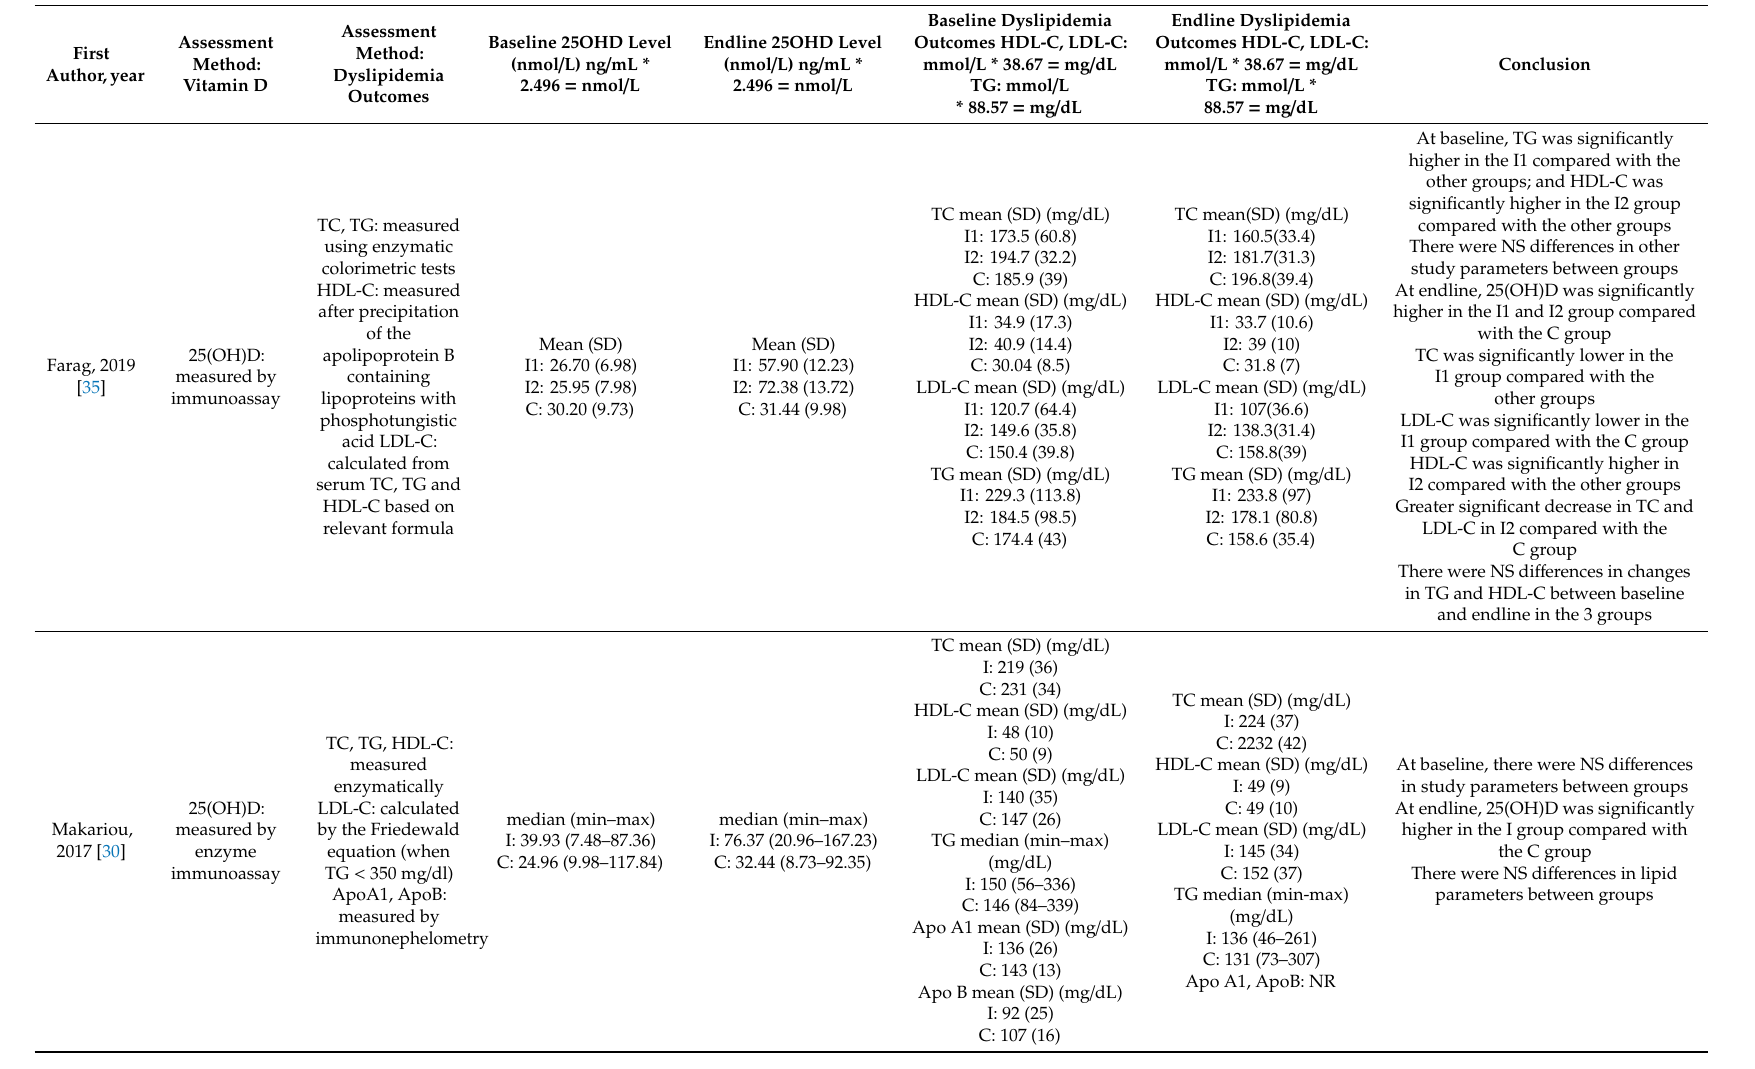
Table 2. Outcomes and results of included